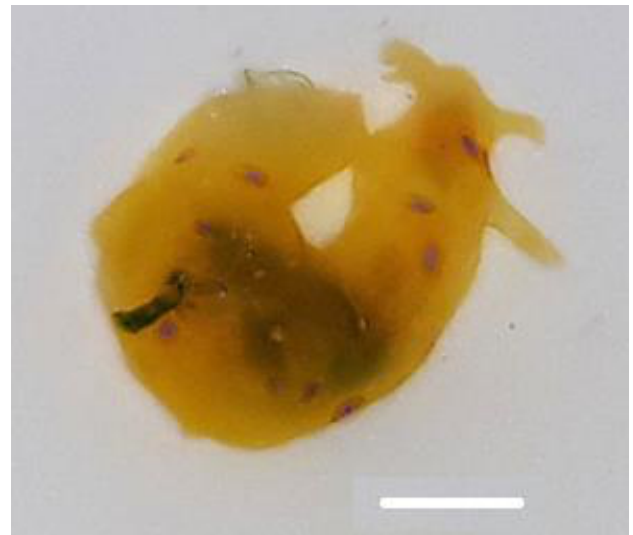
F IGURE 1. Live specimen of S. longicauda from the Persian